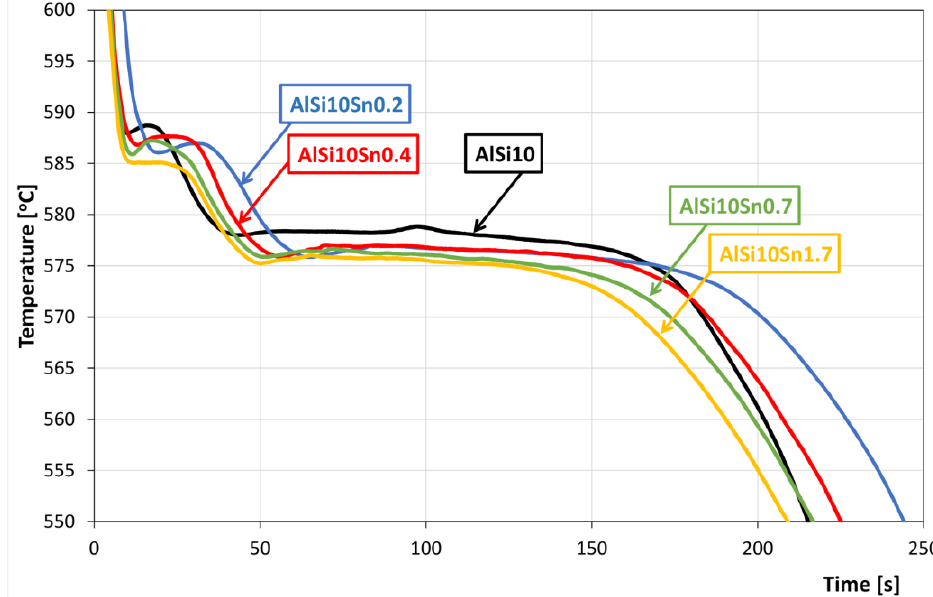
Figure 1. Cooling curves of AlSi10Sn alloys.